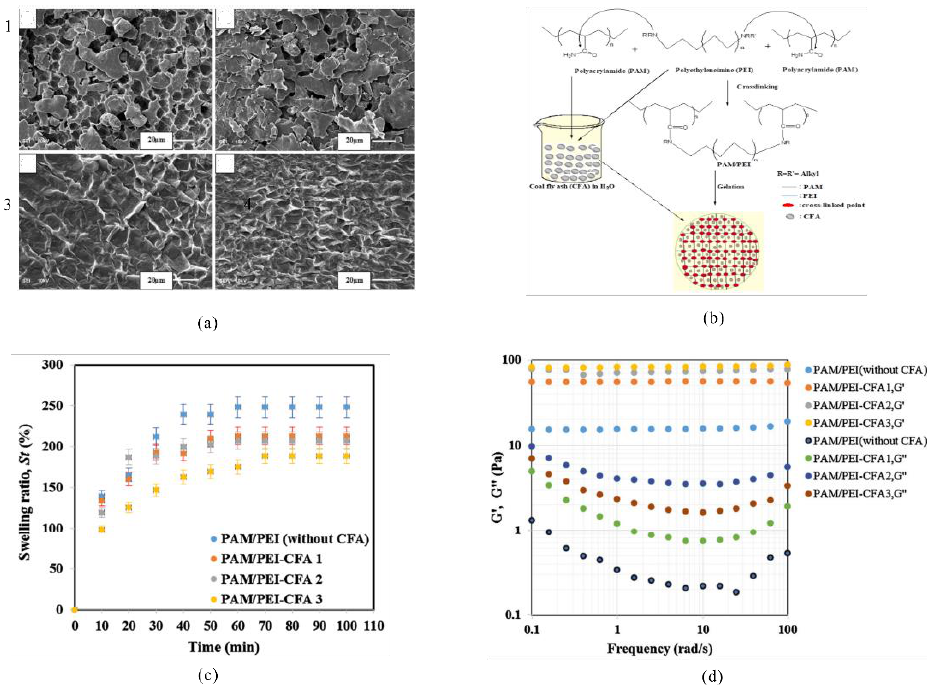
Figure 14. Comparison of preparation principle and performance of PAM/PEI and PAM/PEI-CFA gels. ( a ) SEM images of hydrogels with different CFA content; ( b ) synthesis route of the AM/PEI- CFA hydrogel; ( c , d ) swelling and rheological properties of hydrogels with different CFA contents. (Reprinted/adapted with permission from Ref. [81]. 2018, Adewunmi, et al.).